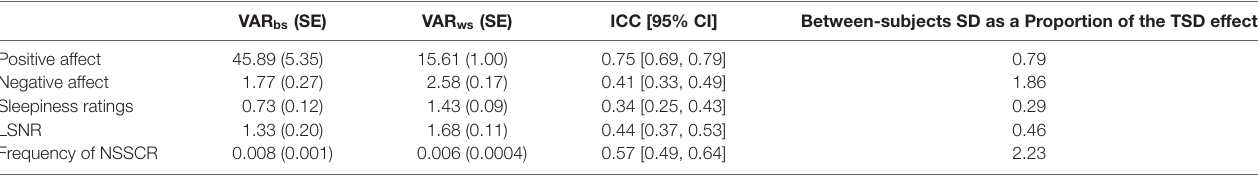
TABLE 3 | Intraclass correlation coefficient